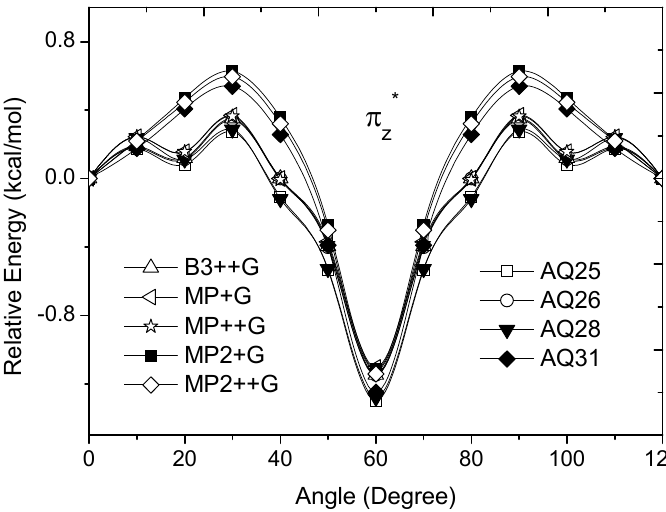
Figure 4. Energy of the occupied MO of ethane as a function of the rotational angle, calculated with the entire theoretical model studied in this work. Labels B3, MP correspond to the B3LYP and mPWB95 functionals, MP2 correspond to the HF theory and the symbols G, +G, and ++G represent the basis set 6-31G(d, p), 6-31+G(d, p), and 6-31++G(d, p),